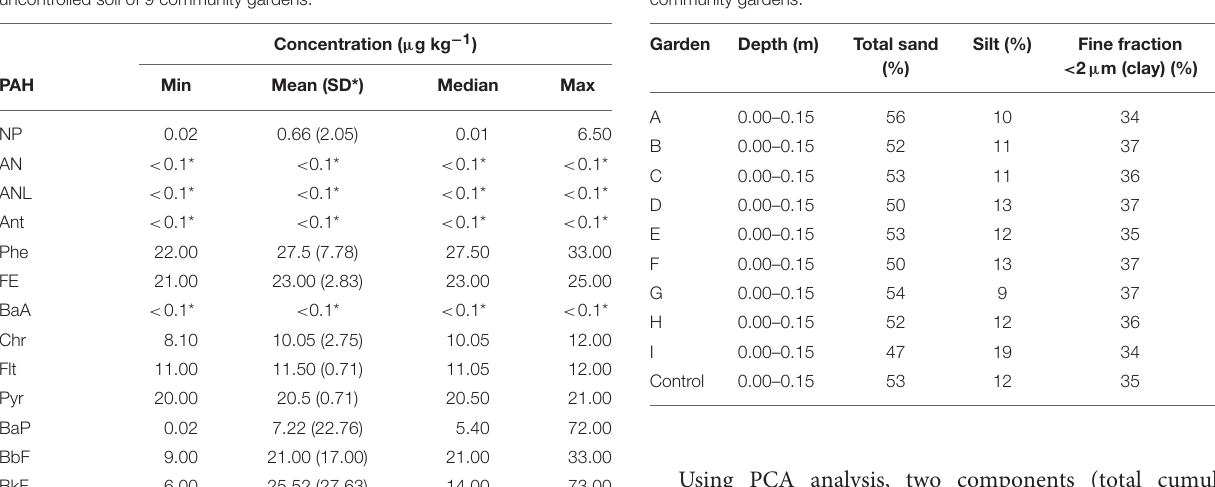
TABLE 4 | Descriptive statistics for the concentrations of 16 PAHs in the uncontrolled soil of 9 community gardens.